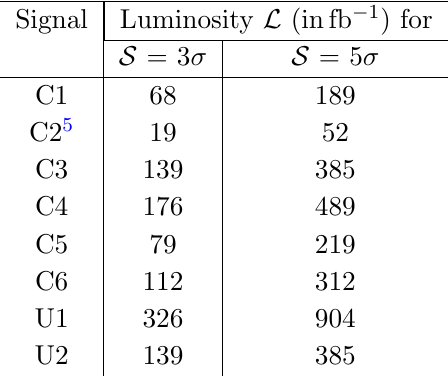
Table 3 . Required luminosity ( L ) to obtain 3 (cid:27) and 5 (cid:27) statistical Signi(cid:12)cance ( S ) of the signal at the 13 TeV run of the LHC corresponding to the benchmark